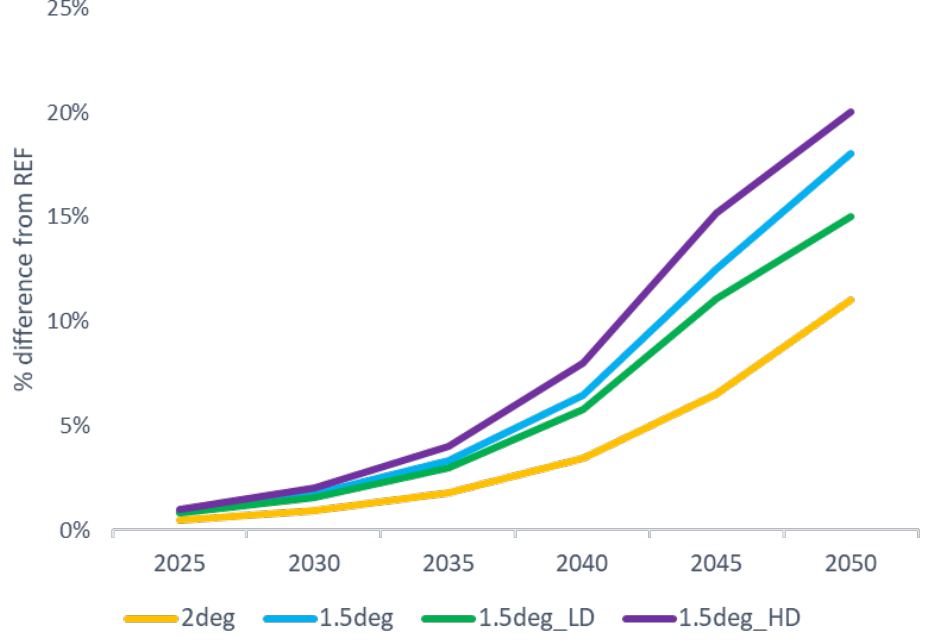
Figure 7. Increase in average aviation cost and airfare price from REF levels.